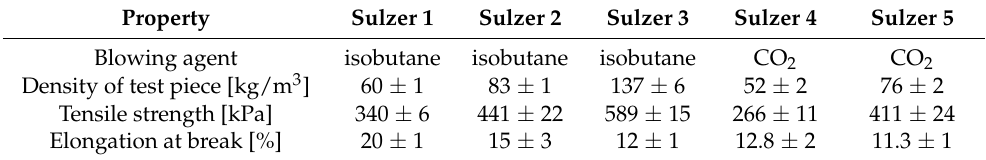
Table 2. Mechanical properties of molded ePP.